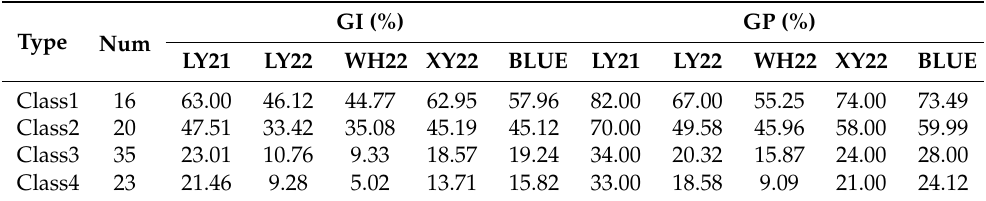
Table 5. GI and GP of four genotypic combinations in the YM16/ZM895 DH population.